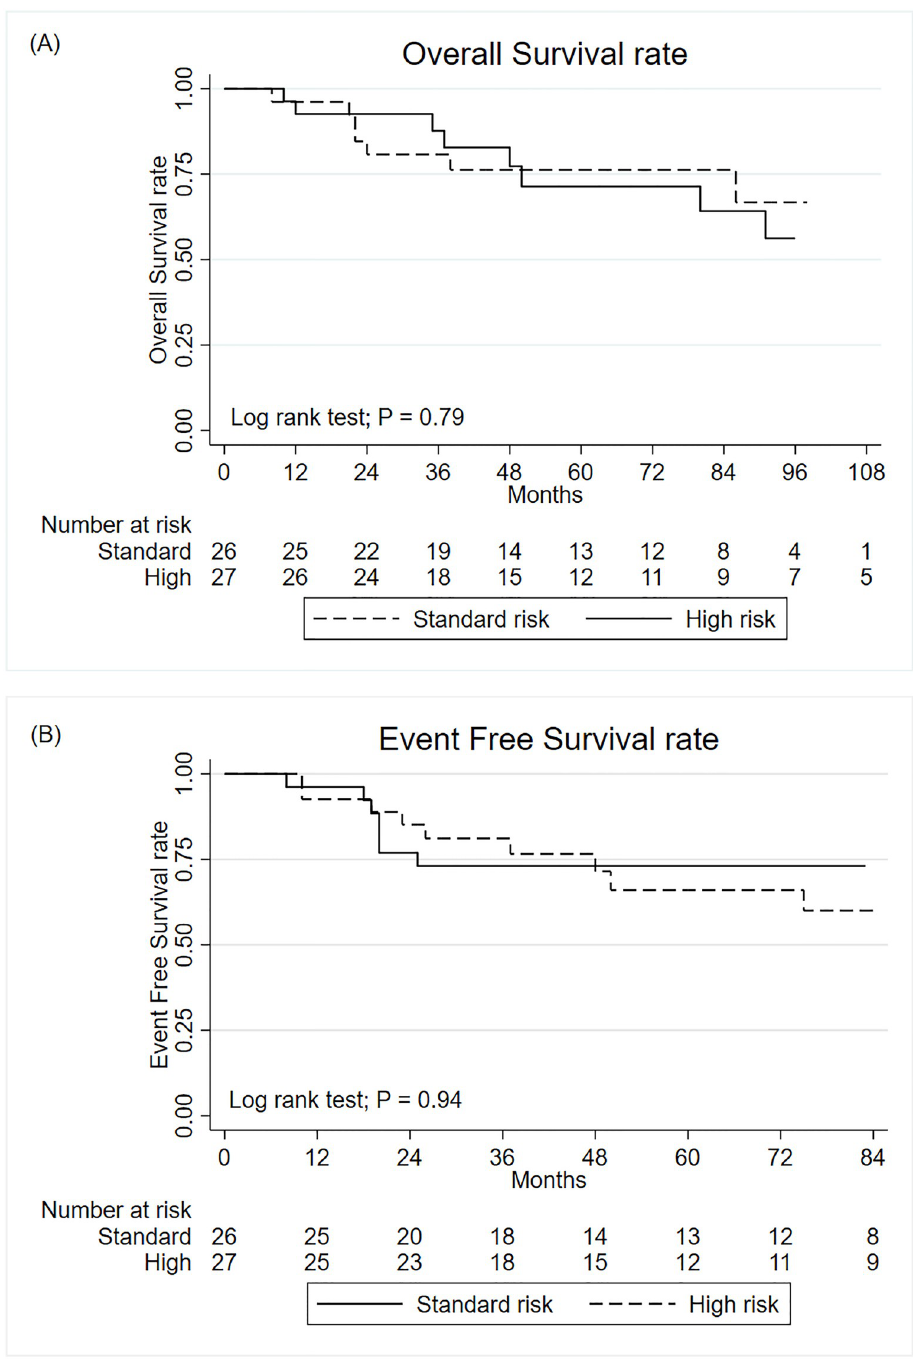
Fig 2. The Kaplan-Meier curve for overall survival (A) and event free survival (B) of pediatric patients from the standard risk and high risk medulloblastoma groups.